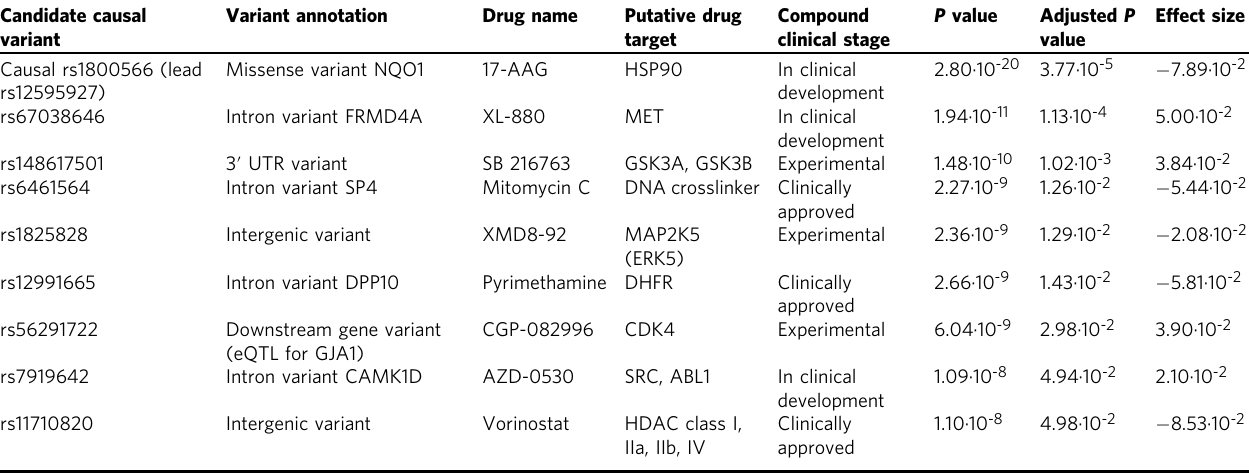
Table 1 Associations between germline variants and drug response Candidate causal